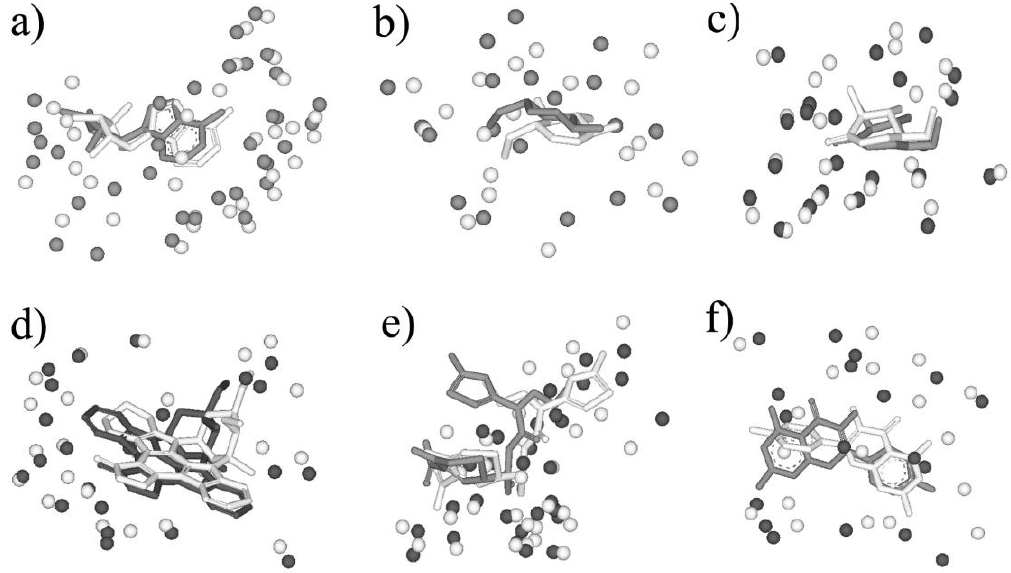
Figure 5. ( a ) The matched binding sites for 5′ -deoxyadenosine between Glutamate mutase (in